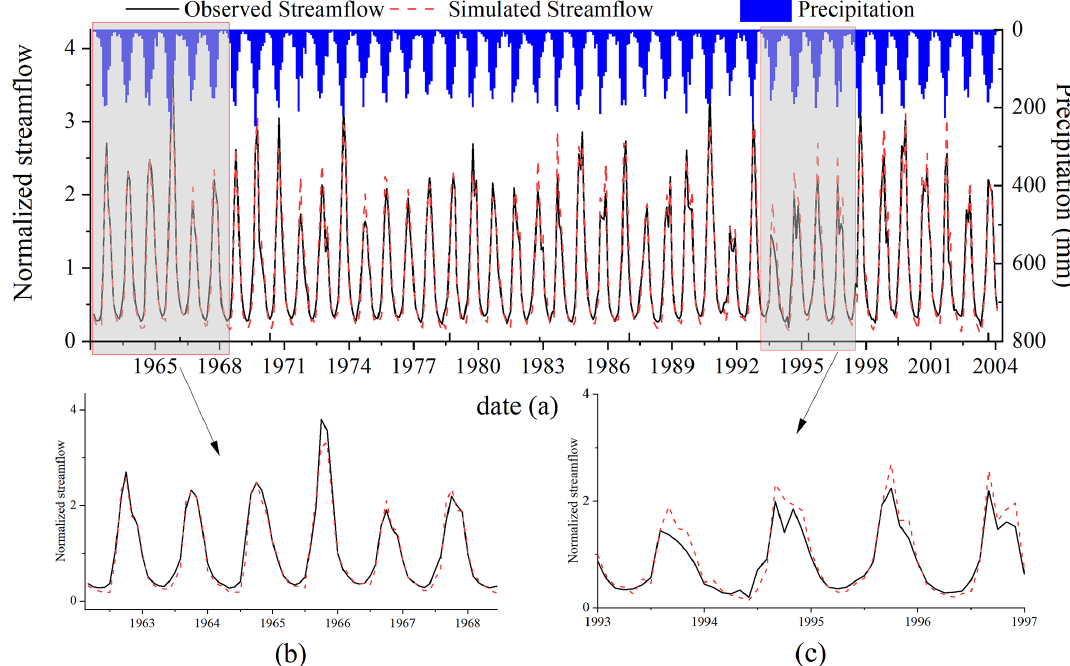
Figure 8. Normalized monthly observed and simulated streamflow at Yunjinghong station for the calibration (from 1963 to 1990) and validation (from 1991 to 2004) periods. The blue histogram shows the monthly precipitation in the LR basin. The normalized streamflow was calculated from the observed and simulated streamflow divided by their average values.